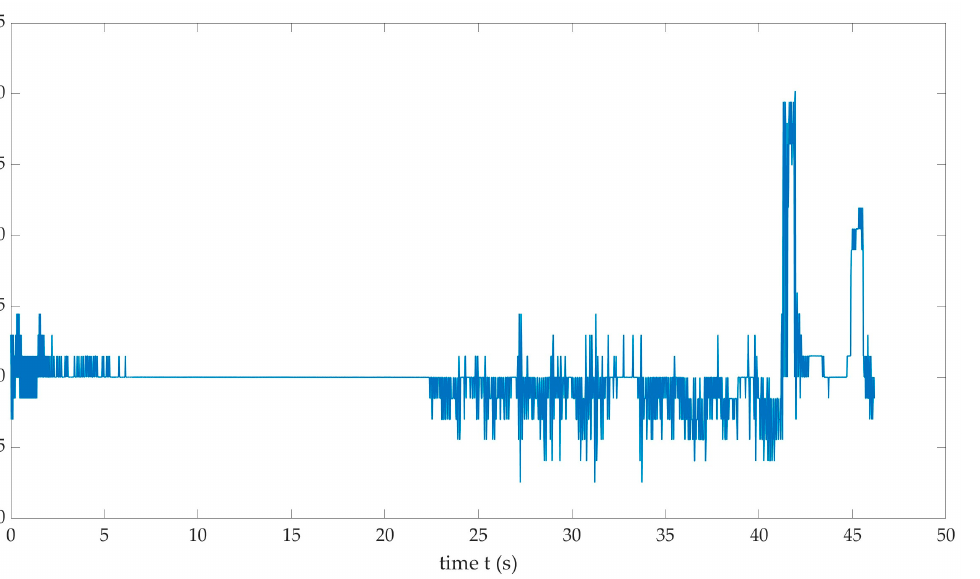
Figure 9. Time series displacement data from GoPro tailplane image sequence, taken from an initial wings level condition. Stall is estimated to be at 22s.